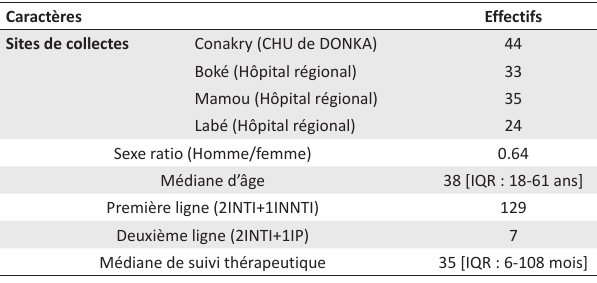
TABLEAU 1: Données liées aux patients en échec virologique (CV ≥ 3 log Sites de collectes Codes des DBS